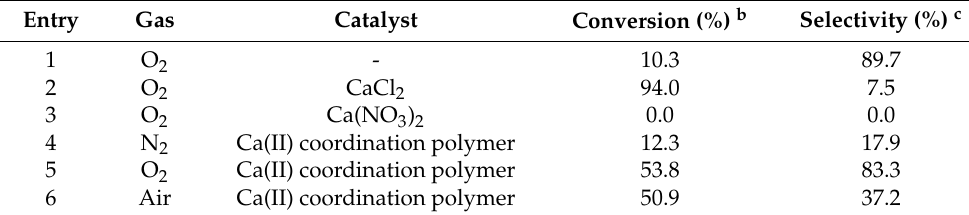
Table 3. Effect of reaction conditions on the benzyl alcohol oxidation a